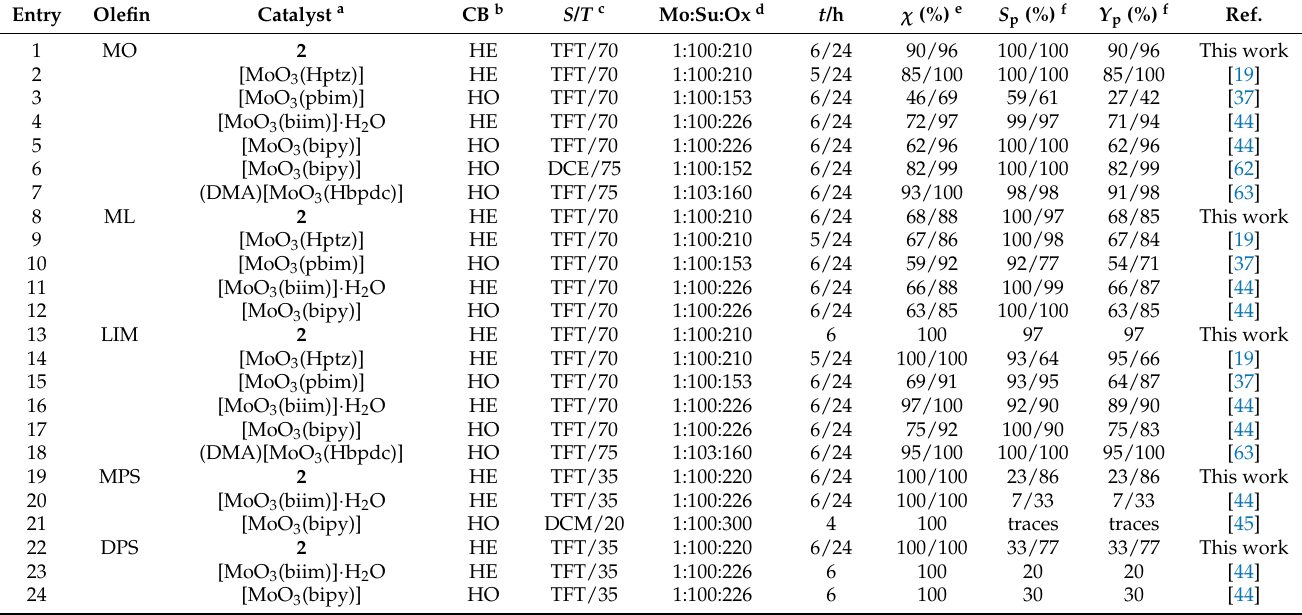
Table 2. Comparison of the catalytic results for 2 with literature data for polymeric hybrids of the